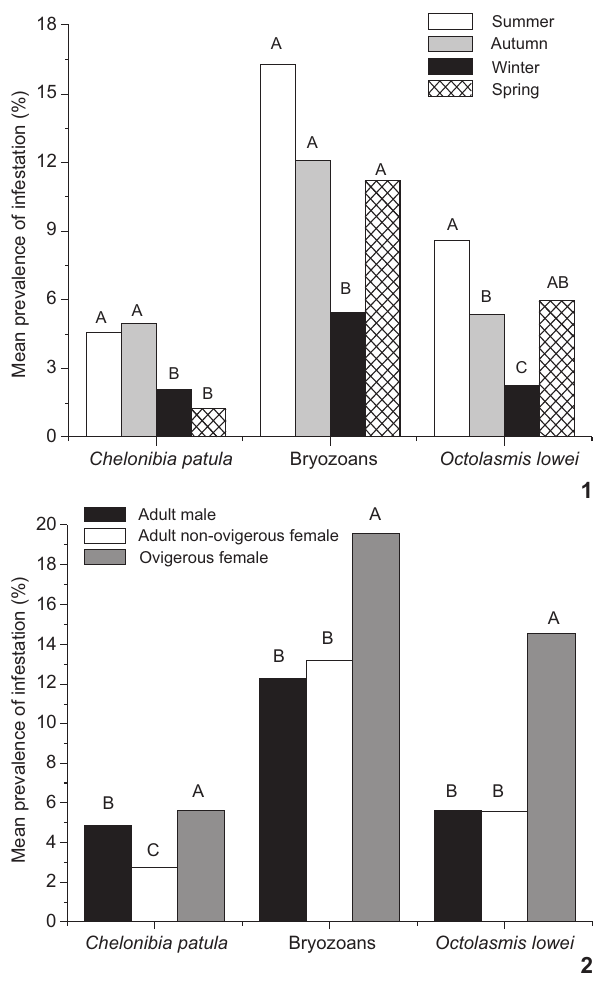
Figures 1-2. Arenaeus cribrarius . Mean prevalence of infestation (%) by C. patula , Bryozoans and O. lowei in relation to the: (1) season; and (2) group of interest (adult male, non-ovigerous adult female, ovigerous female). Equal letters on the same group of vertical bars in each figure denote non-significant differences (p >